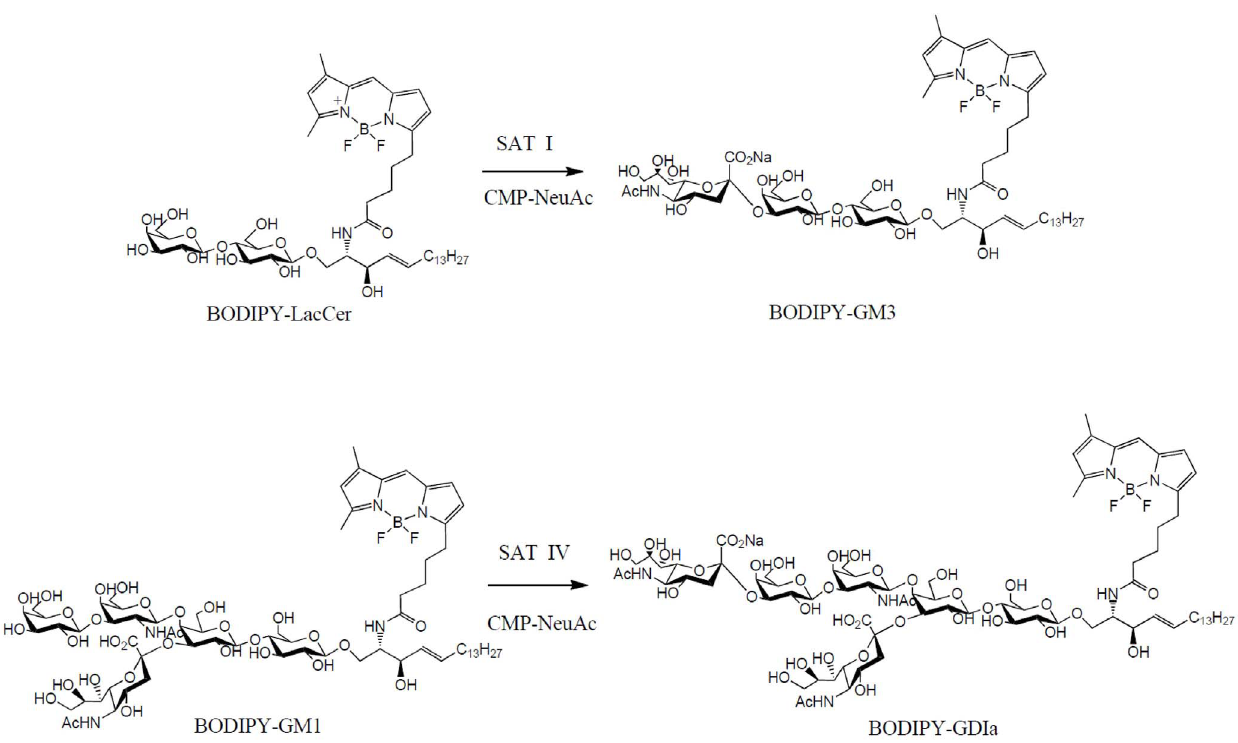
Figure 1. Enzymatic reaction schemes in the proposed ganglioside sialyltransferase assay; the reaction on the top describes the conversion of BODIPY-LacCer to BODIPY-GM3 by the action of SAT I; the reaction scheme below uses BODIPY-GM1 as the acceptor